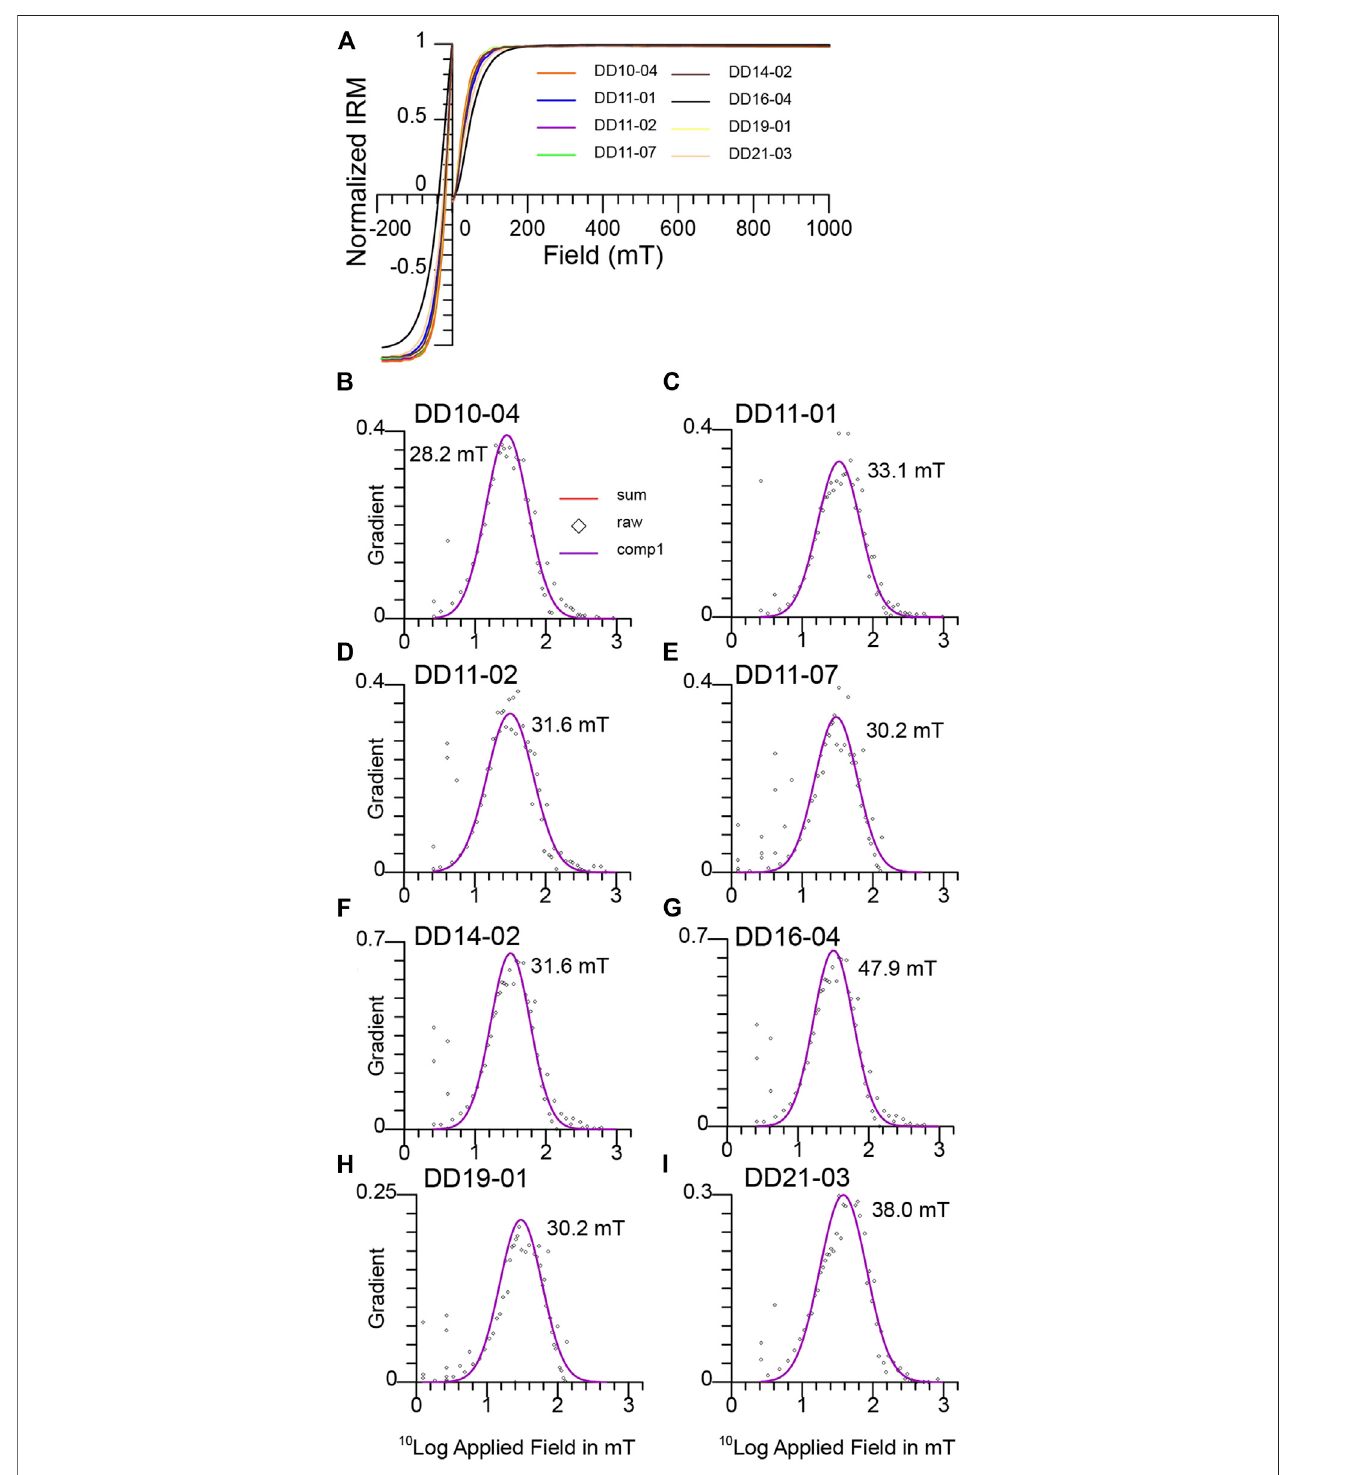
FIGURE 3 | (A) IRM acquisition curves of representative samples (B – I) IRM decomposition curves of these samples.